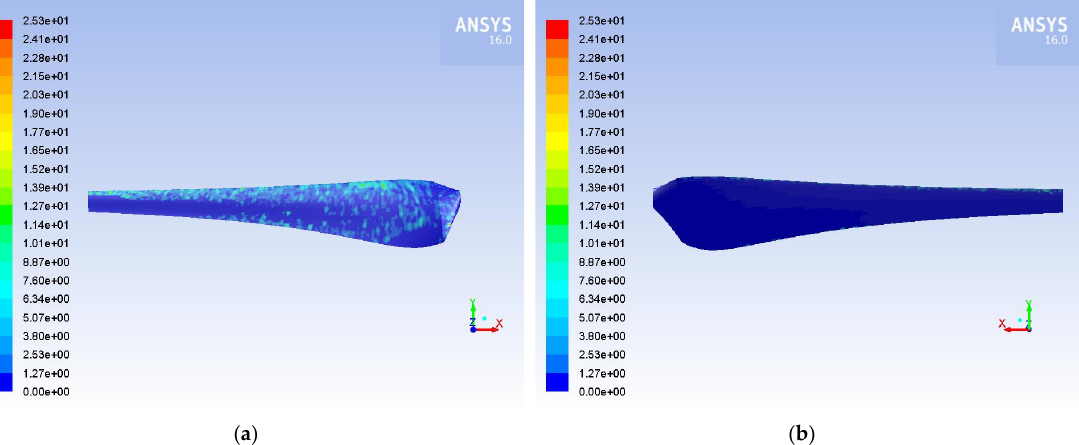
Figure 11. Concentration of sand particles close to the wind turbine rotor for: ( a ) u = 10 m·s − 1 , Q = 1%; ( b ) u = 15 m·s − 1 , Q = 1%; ( c ) u = 10 m·s − 1 , Q = 5%; ( d ) u = 15 m·s − 1 , Q = 5%; ( e ) u = 10 m·s − 1 , Q = 10%; ( f ) u = 15 m·s − 1 , Q = 10%.